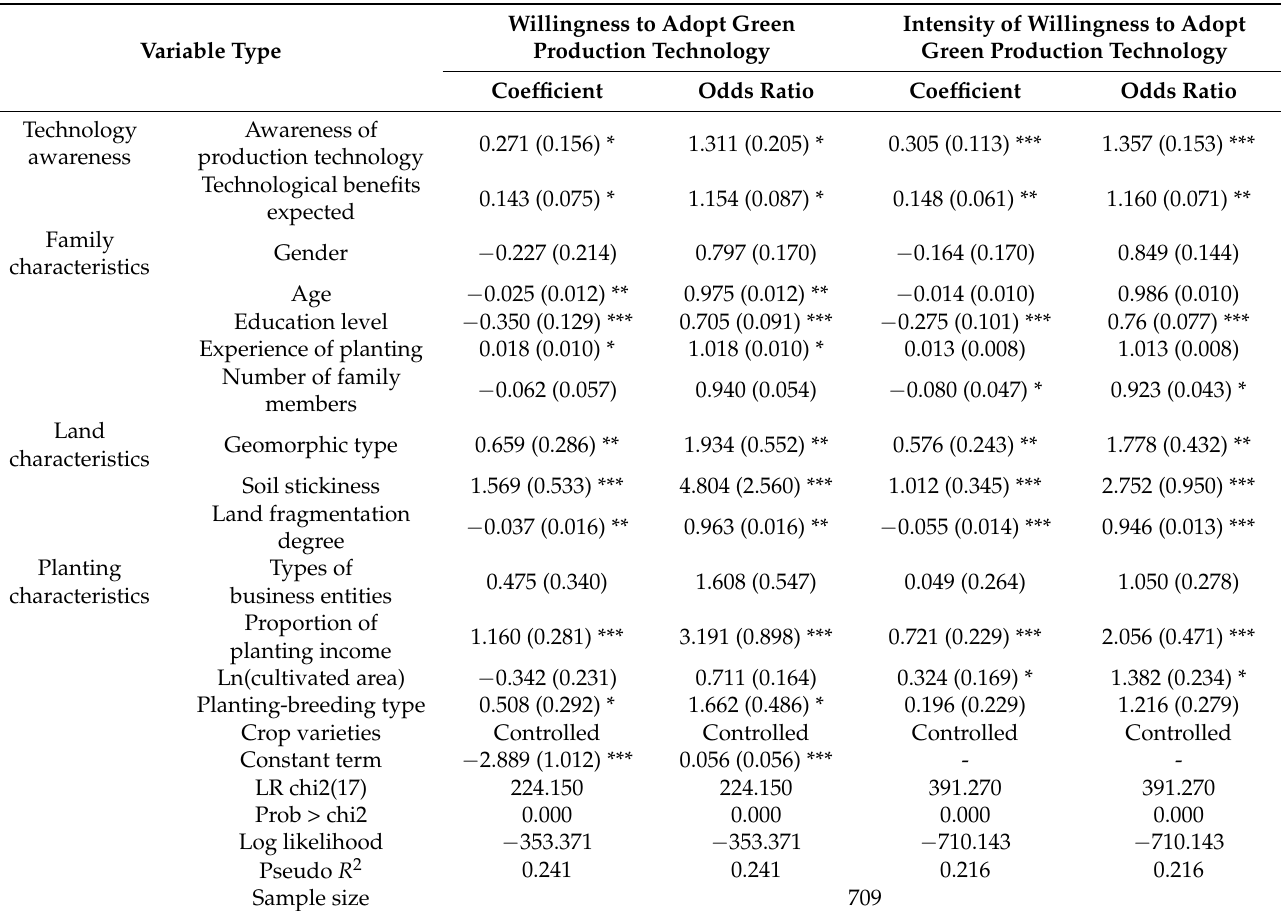
Table 2. The results of the model fitting of factors influencing the willingness to adopt green production